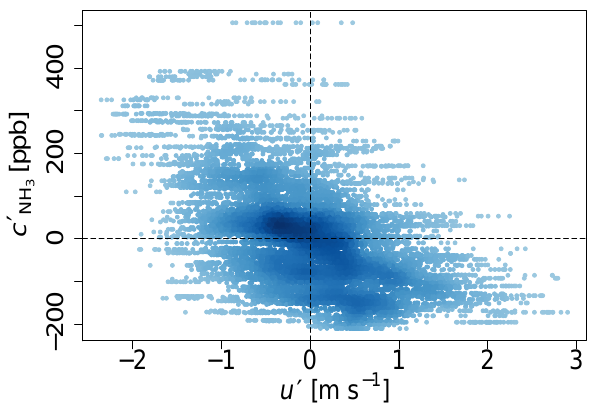
Fig. 4. One 10 min interval of c 0 vs. u 0 measured by EC using CIMS following slurry spreading (splash plate) on arable land (Sintermann et al., 2011a), 4 August